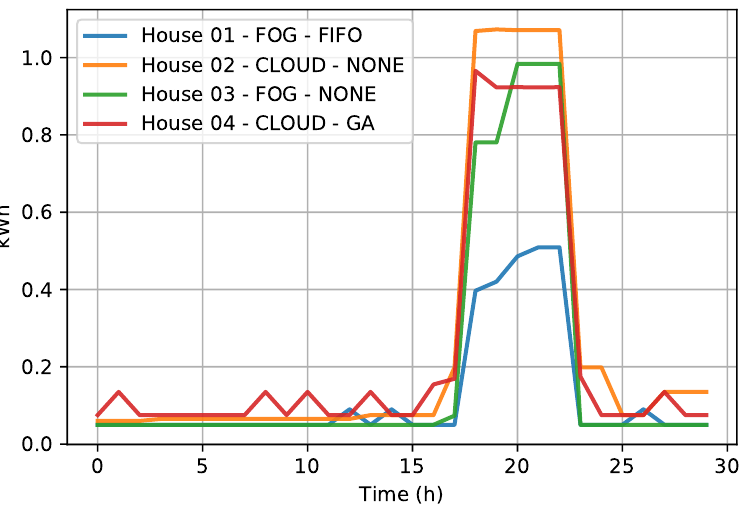
Figure 6. Comparison of power management algorithms and